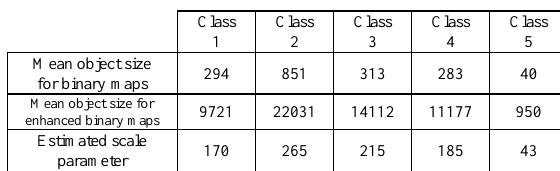
Figure 5. A small part of original image and its SSS